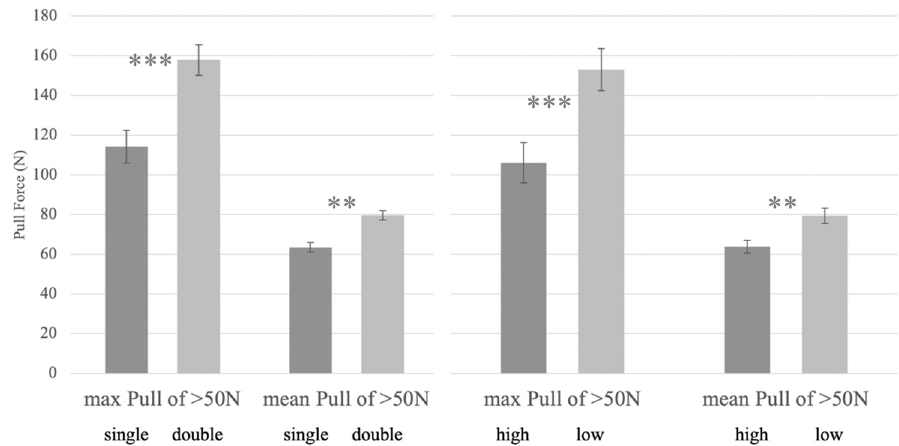
Figure 4. Mean and Mean max pull pressure >50 N recorded for 6 horses eating from either a single or double layered haynet and when hung low or high (s.e. bars shown; *** p < 0.001; ** p < 0.01;